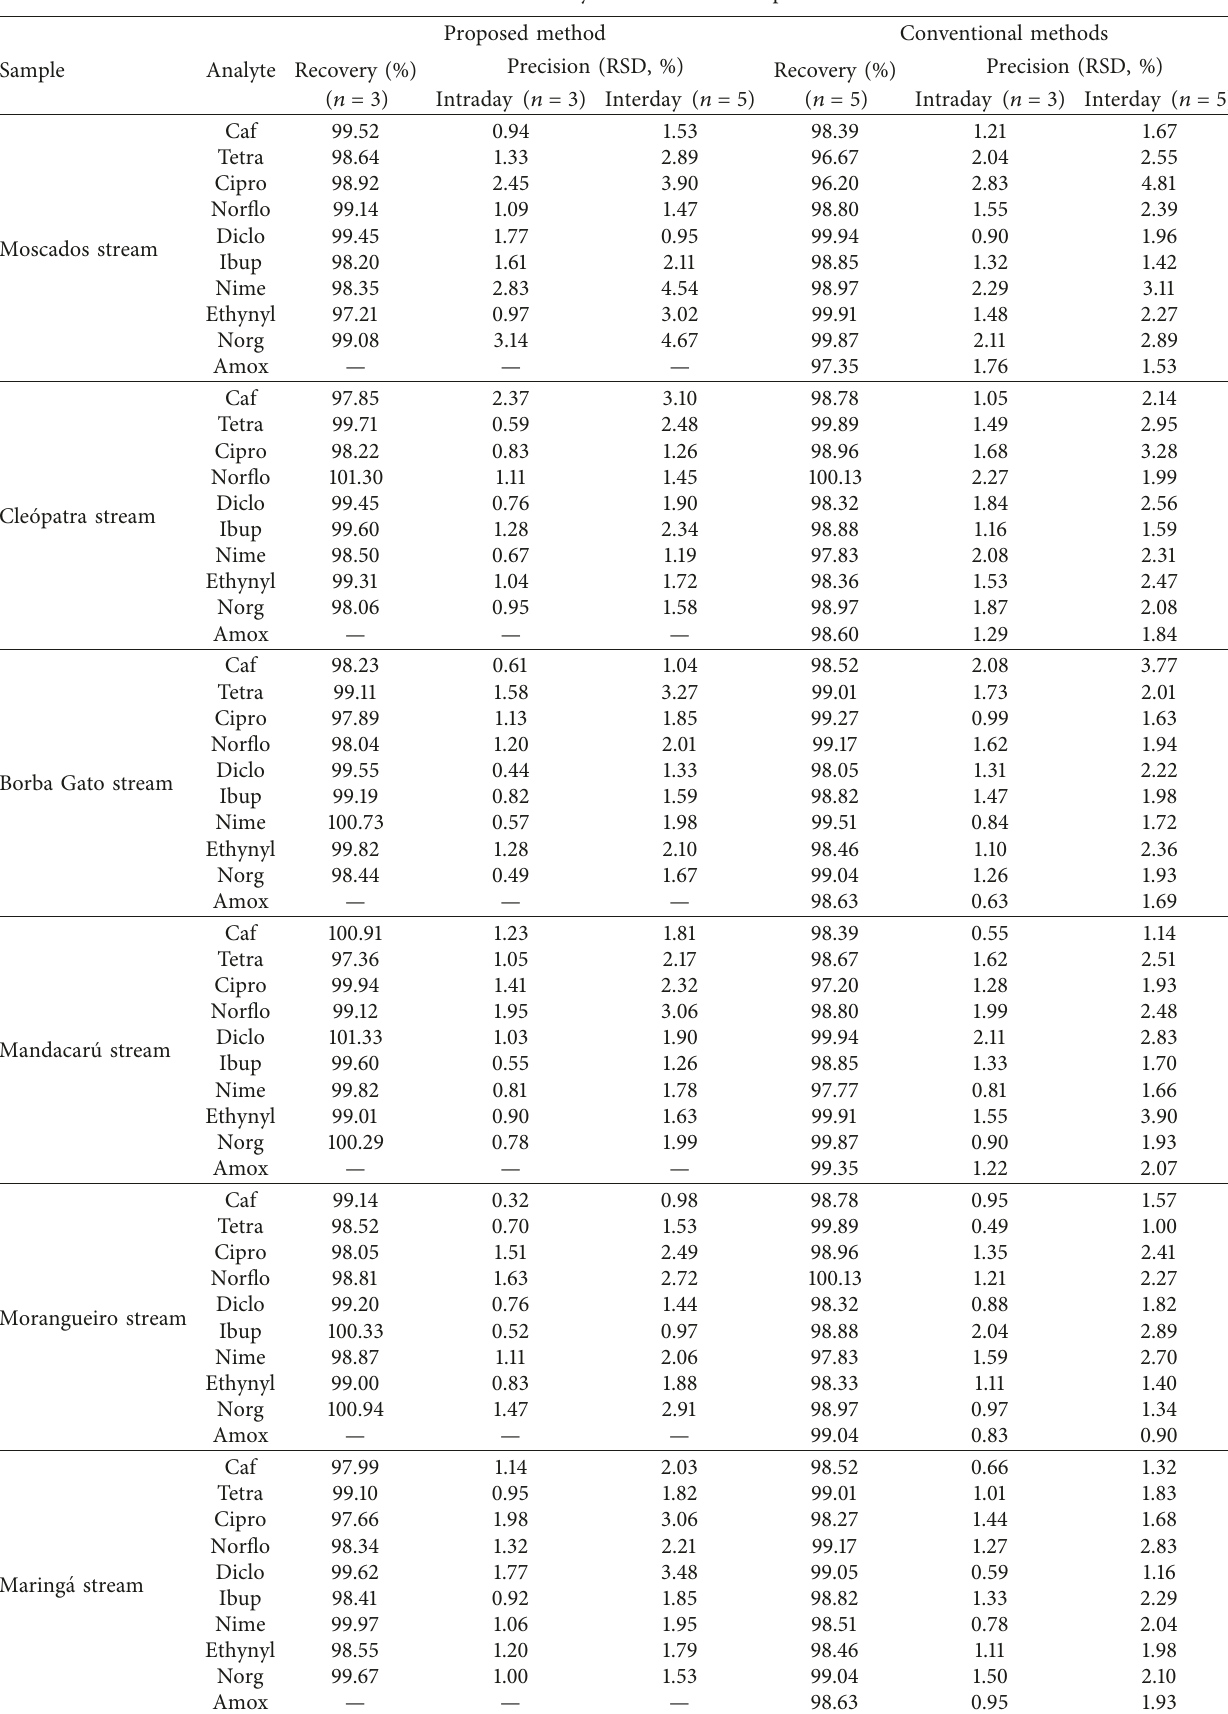
Table 5: Recovery tests for water